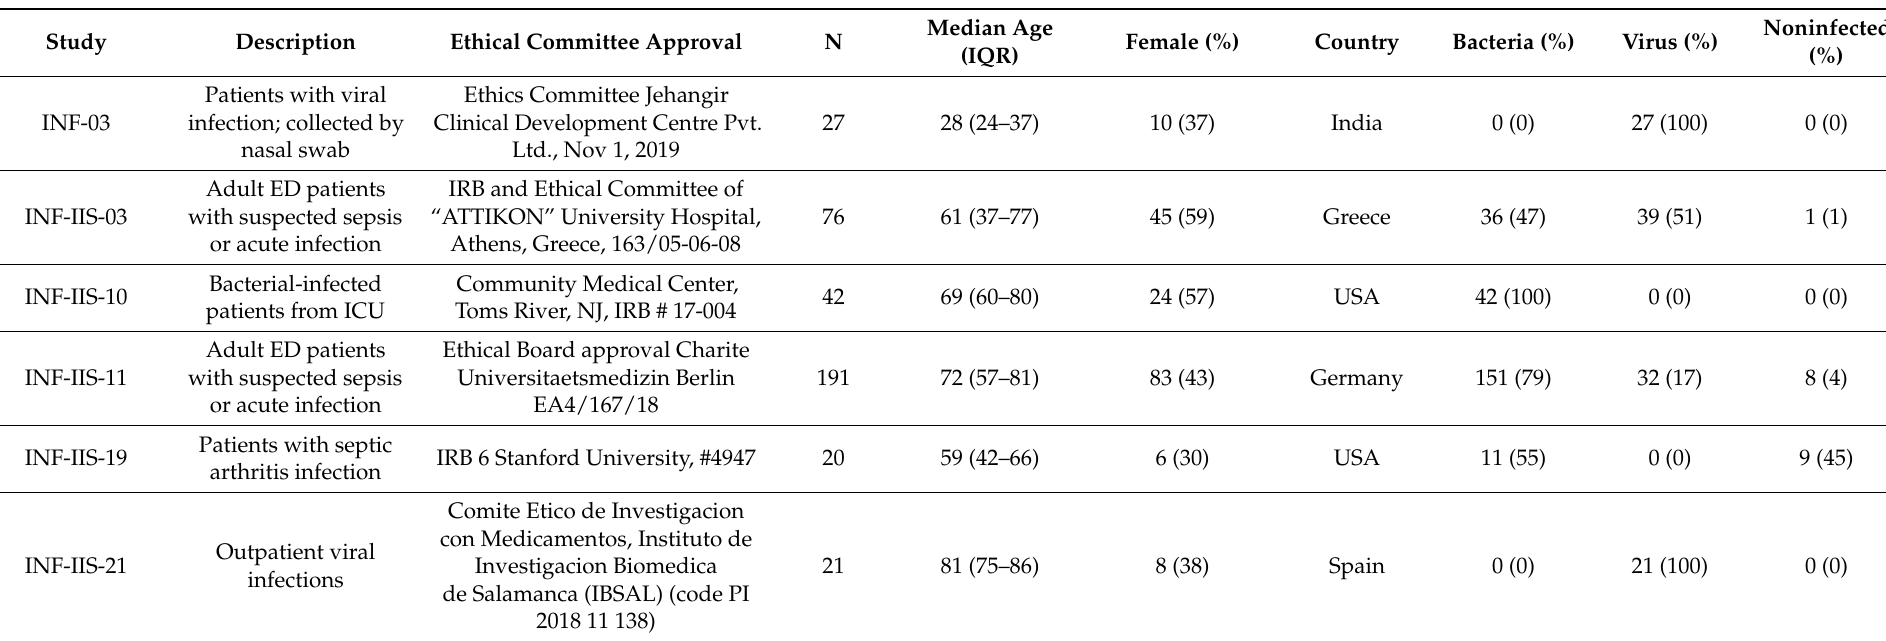
Table 3. Patient characteristics and composition of datasets used in validation for marker swap optimization. All samples were profiled on the NanoString platform. ICU = intensive care unit; ED = emergency